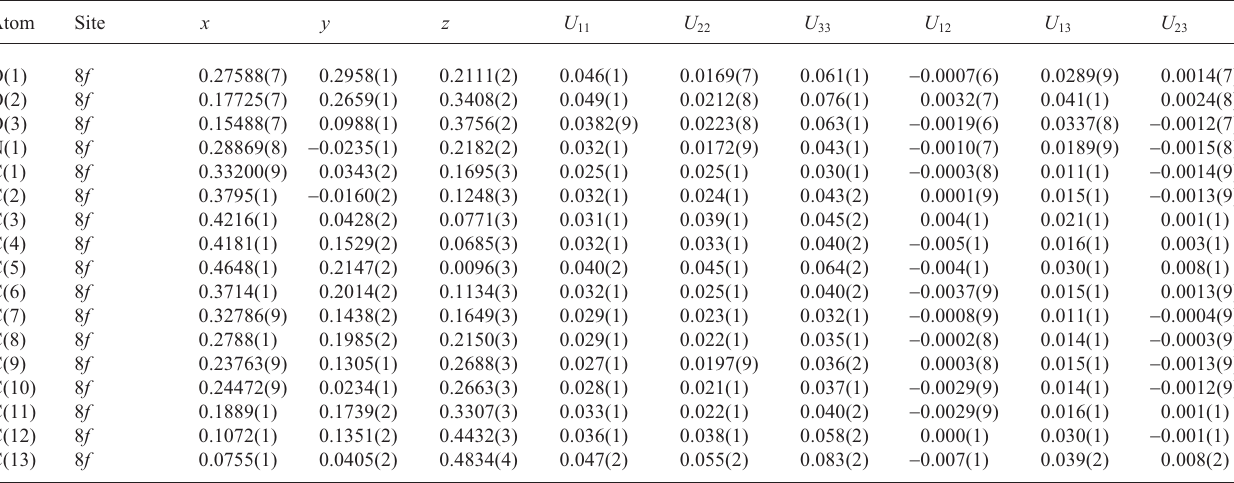
Table 3. Atomic coordinates and displacement parameters (in Å 2 )